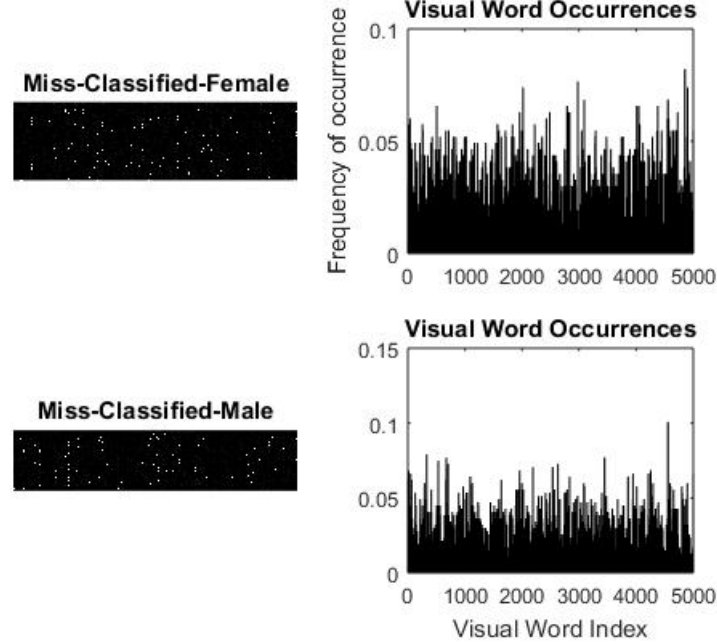
Fig. 6. Histogram of misclassified